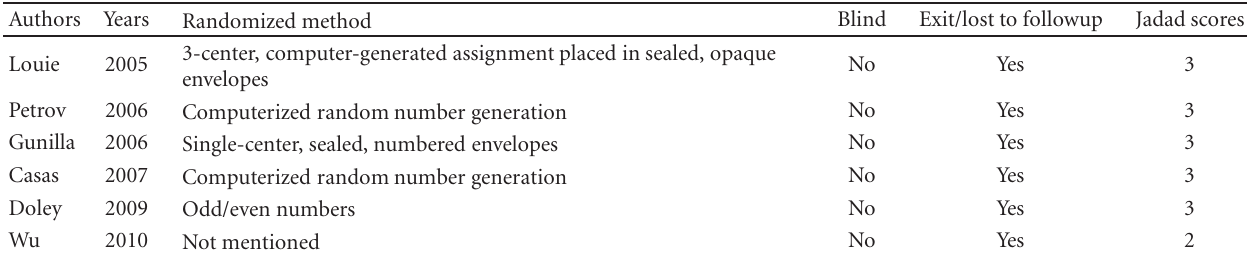
Table 3: E ff ective endpoint of every